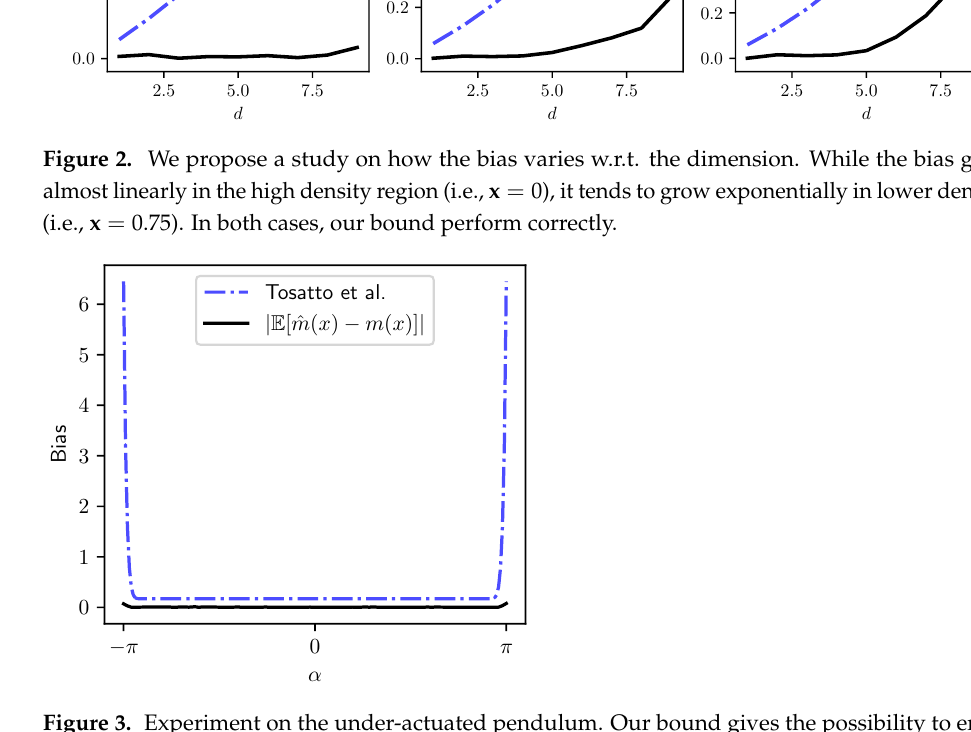
Figure 3. Experiment on the under-actuated pendulum. Our bound gives the possibility to ensure ˆ m ( x )] does not exceed a certain quantity. In this example, it is possible to observe that that E [ m ( x ) − the bias is correctly